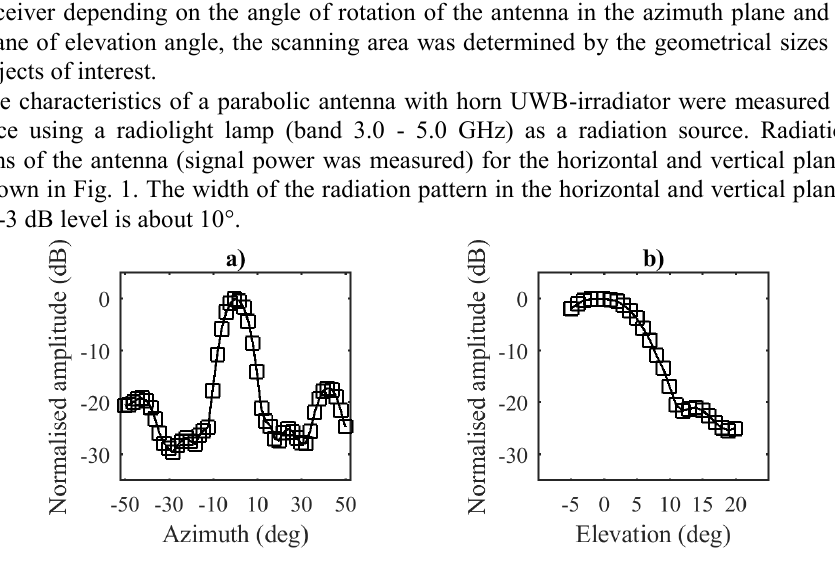
Fig. 1. Radiation power patterns for a parabolic antenna with a horn UWB-irradiator measured with a radiolight lamp (3-5 GHz band) as a radiation source: a) in the horizontal plane, b) in the vertical